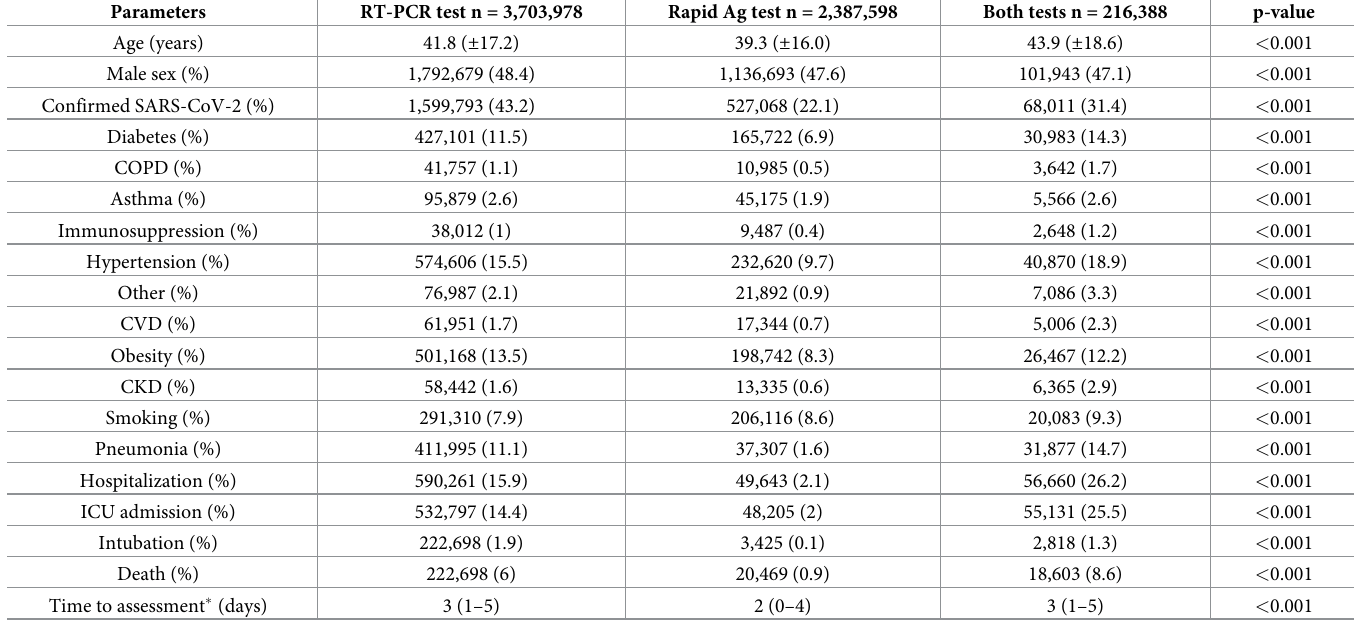
Table 1. Characteristics of subjects tested for SARS-CoV-2 infection in Mexico, comparing cases who were tested using qRT-PCR, rapid antigen tests and a combi- nation of both.